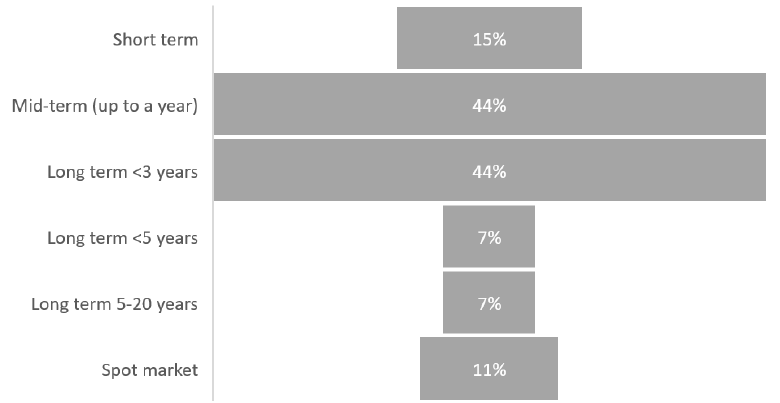
Figure 1. Preferred biomass supply contract period among the surveyed bioenergy facilities ( n = 27).